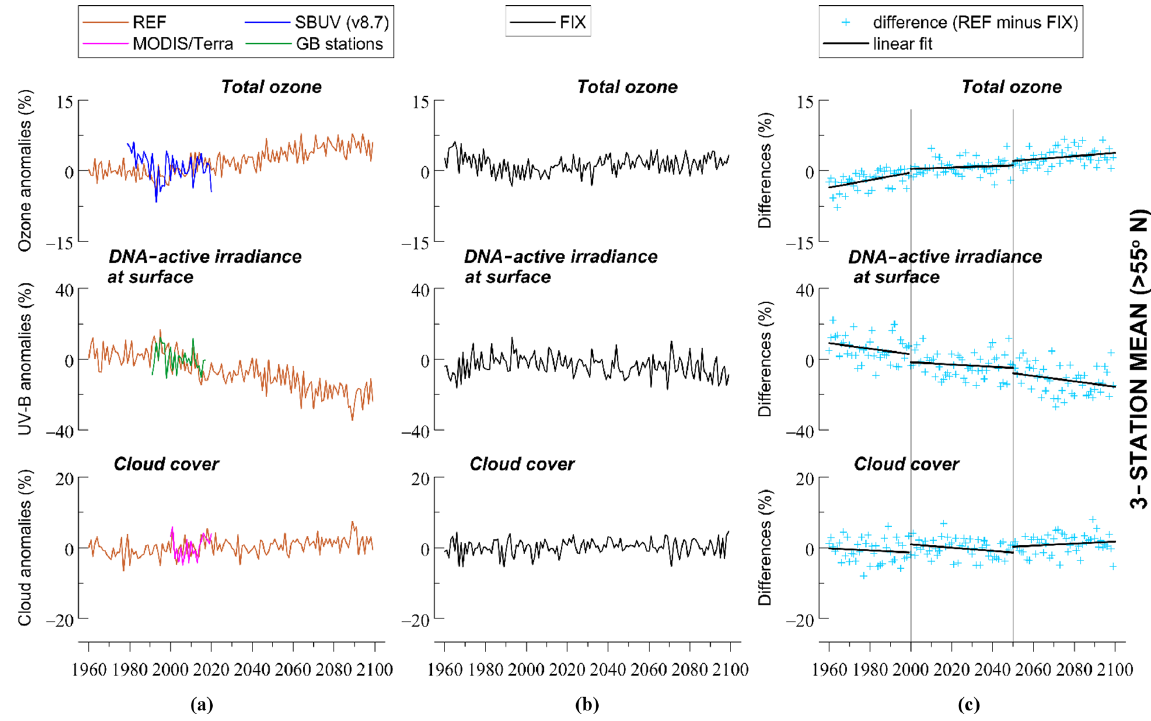
Figure 5. Same as Fig. 4 but for three UV stations in the northern high latitudes ( > 55 ◦ N). The y axes in (a) and (b) show averages of monthly de-seasonalized anomalies from March to